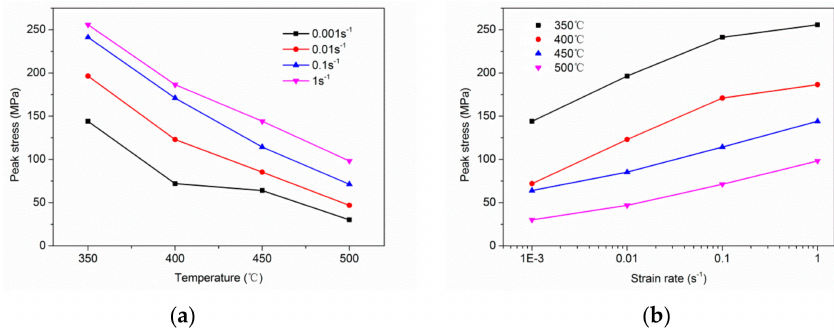
Figure 5. Relationship among flow stress, ( a ) deformation temperature and ( b ) strain